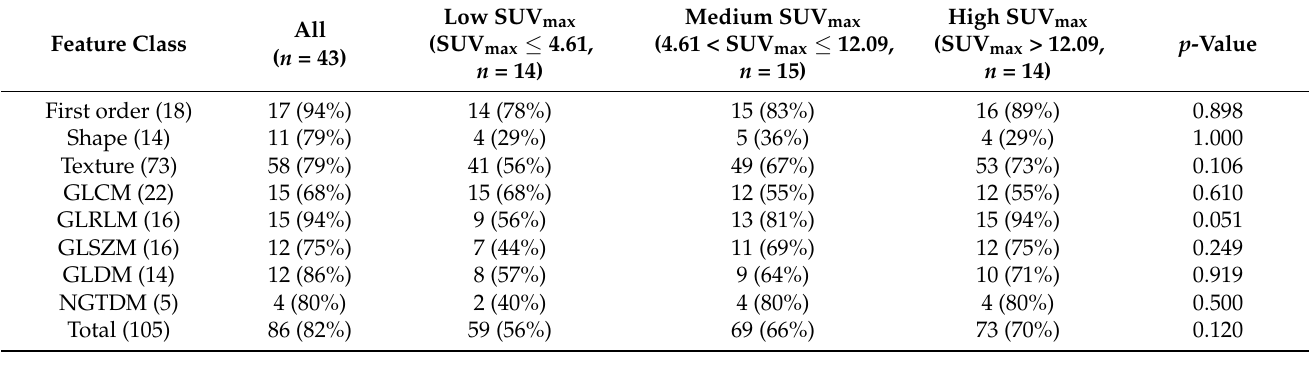
Table 4. Numbers and percentages of features affected by the delineation method (VOI vital-tumour vs. VOI gross-tumour ) per feature class for the different subgroups based on SUV max . Differences in the number of affected features between subgroups were assessed using the Fisher’s exact test. SUV max : maximum standardised uptake value, GLCM: grey level co-occurrence matrix, GLRLM: grey level run length matrix, GLSZM: grey level size zone matrix, GLDM: grey level dependence matrix, NGTDM: neighbouring grey tone difference matrix.